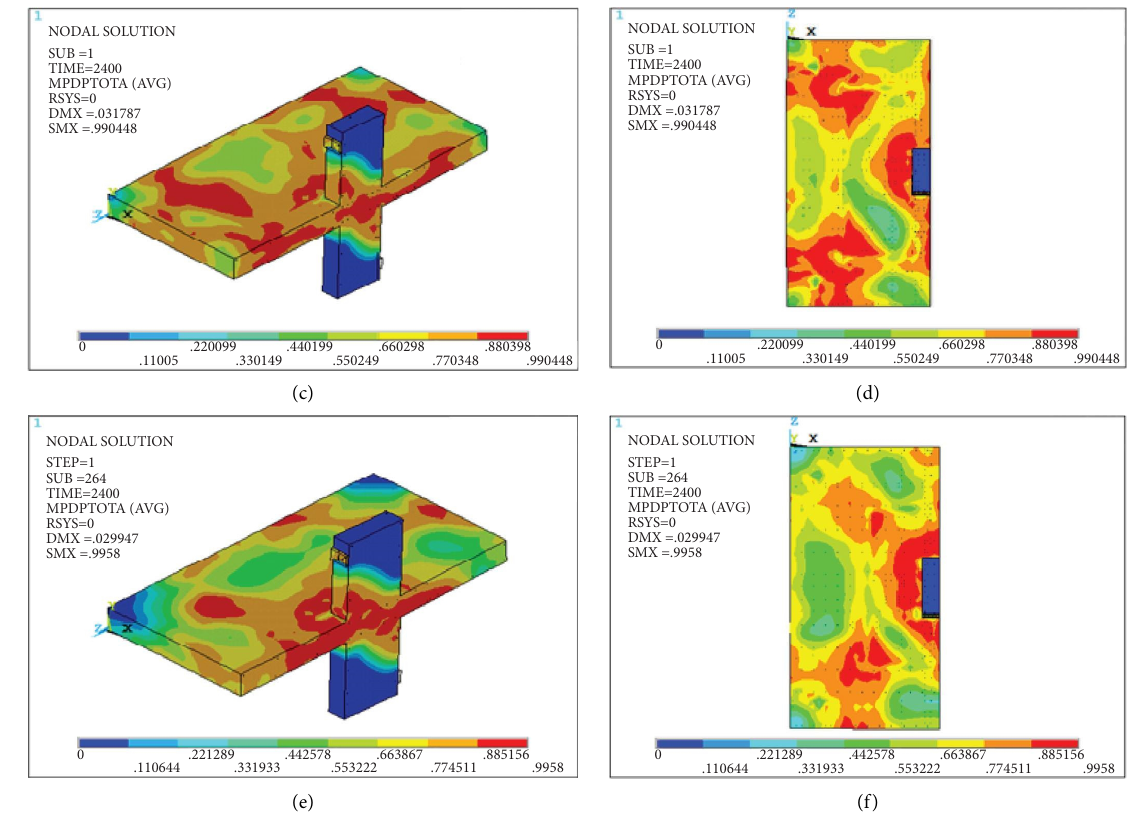
Figure 43: Concrete damage of specimens with varying column aspect ratio. (a) Specimen 200-45-1.166-ALL BS-2400. (b) Bottom surface. (c) Specimen 200-45-1.333-ALL BS-2400. (d) Bottom surface. (e) Specimen 200-45-1.666-ALL BS-2400. (f) Bottom